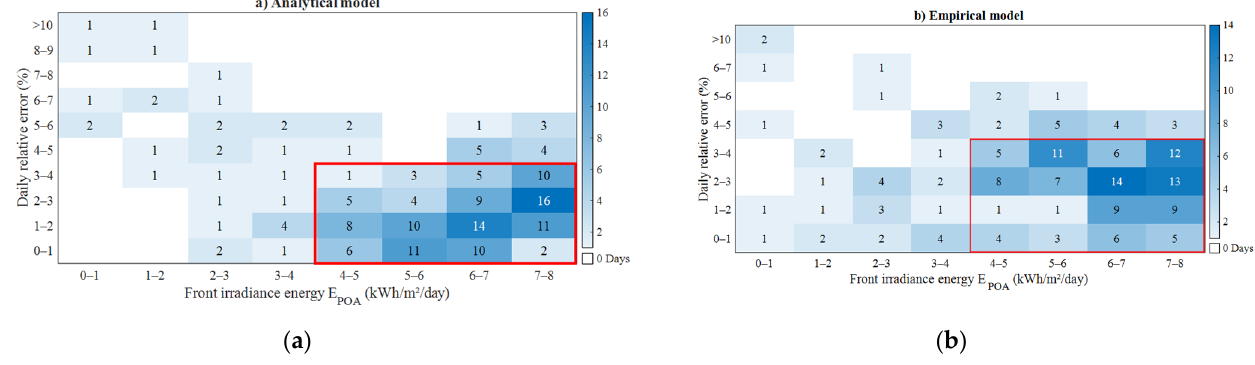
Figure 12. Heatmap of the daily errors of the analytical and the empirical models for bifacial modules with normal albedo. ( a ) Daily relative error distribution using the analytical model. ( b ) Daily relative error distribution using the empirical model. The number of days were 125 and 114, respectively.